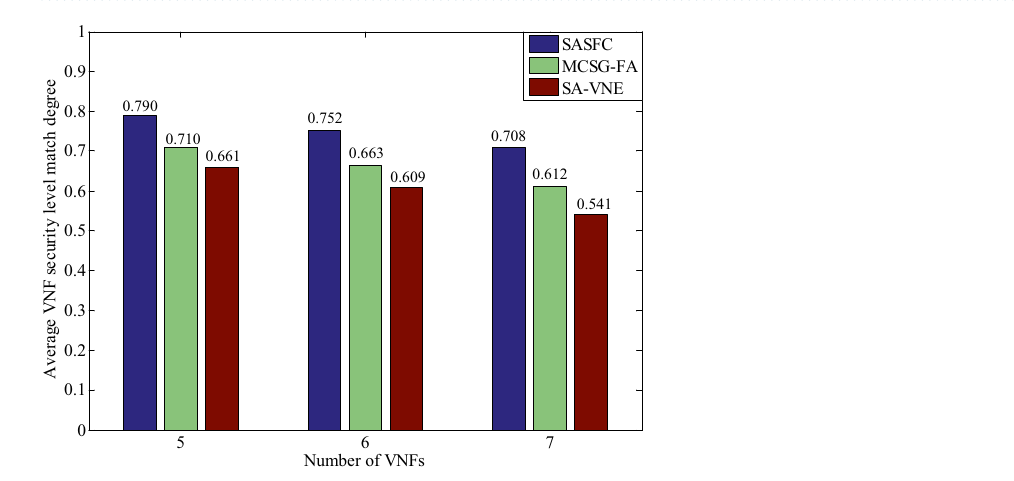
Figure 8. Average VNF security level match